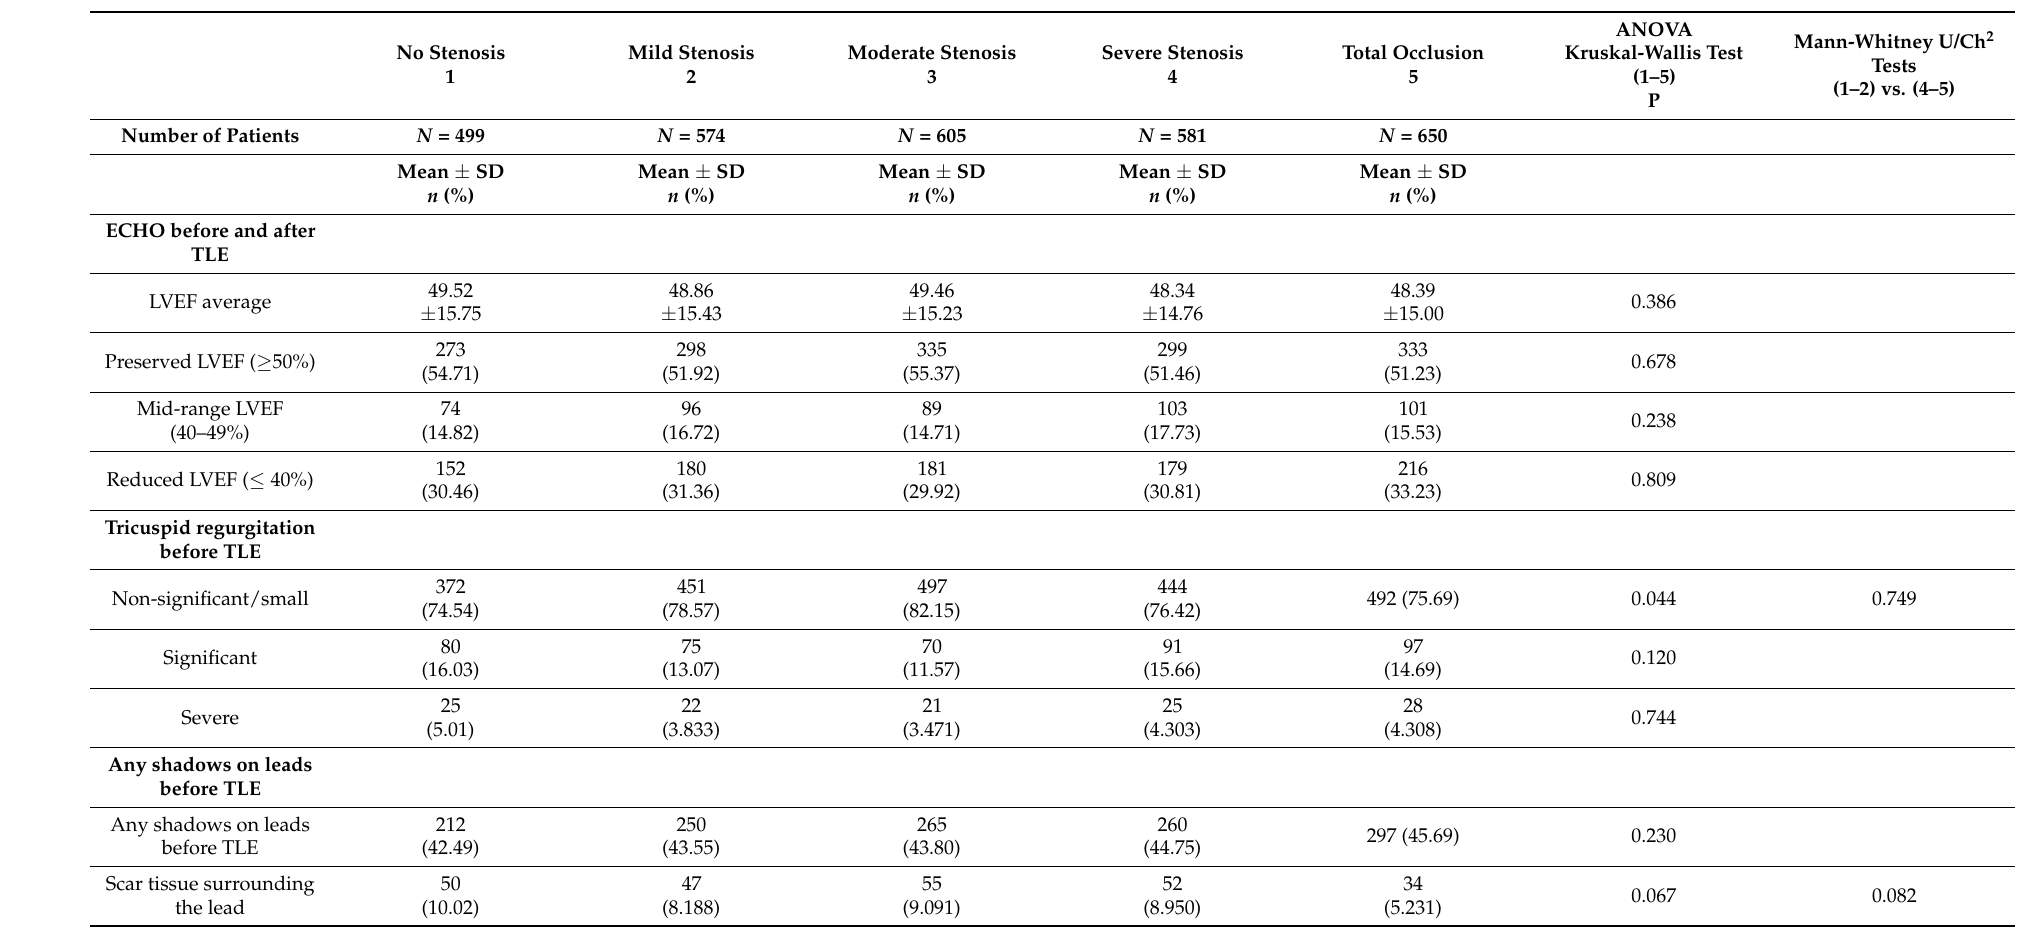
Table 3. Echocardiographic findings/abnormalities in patients with various degrees of lead-related venous